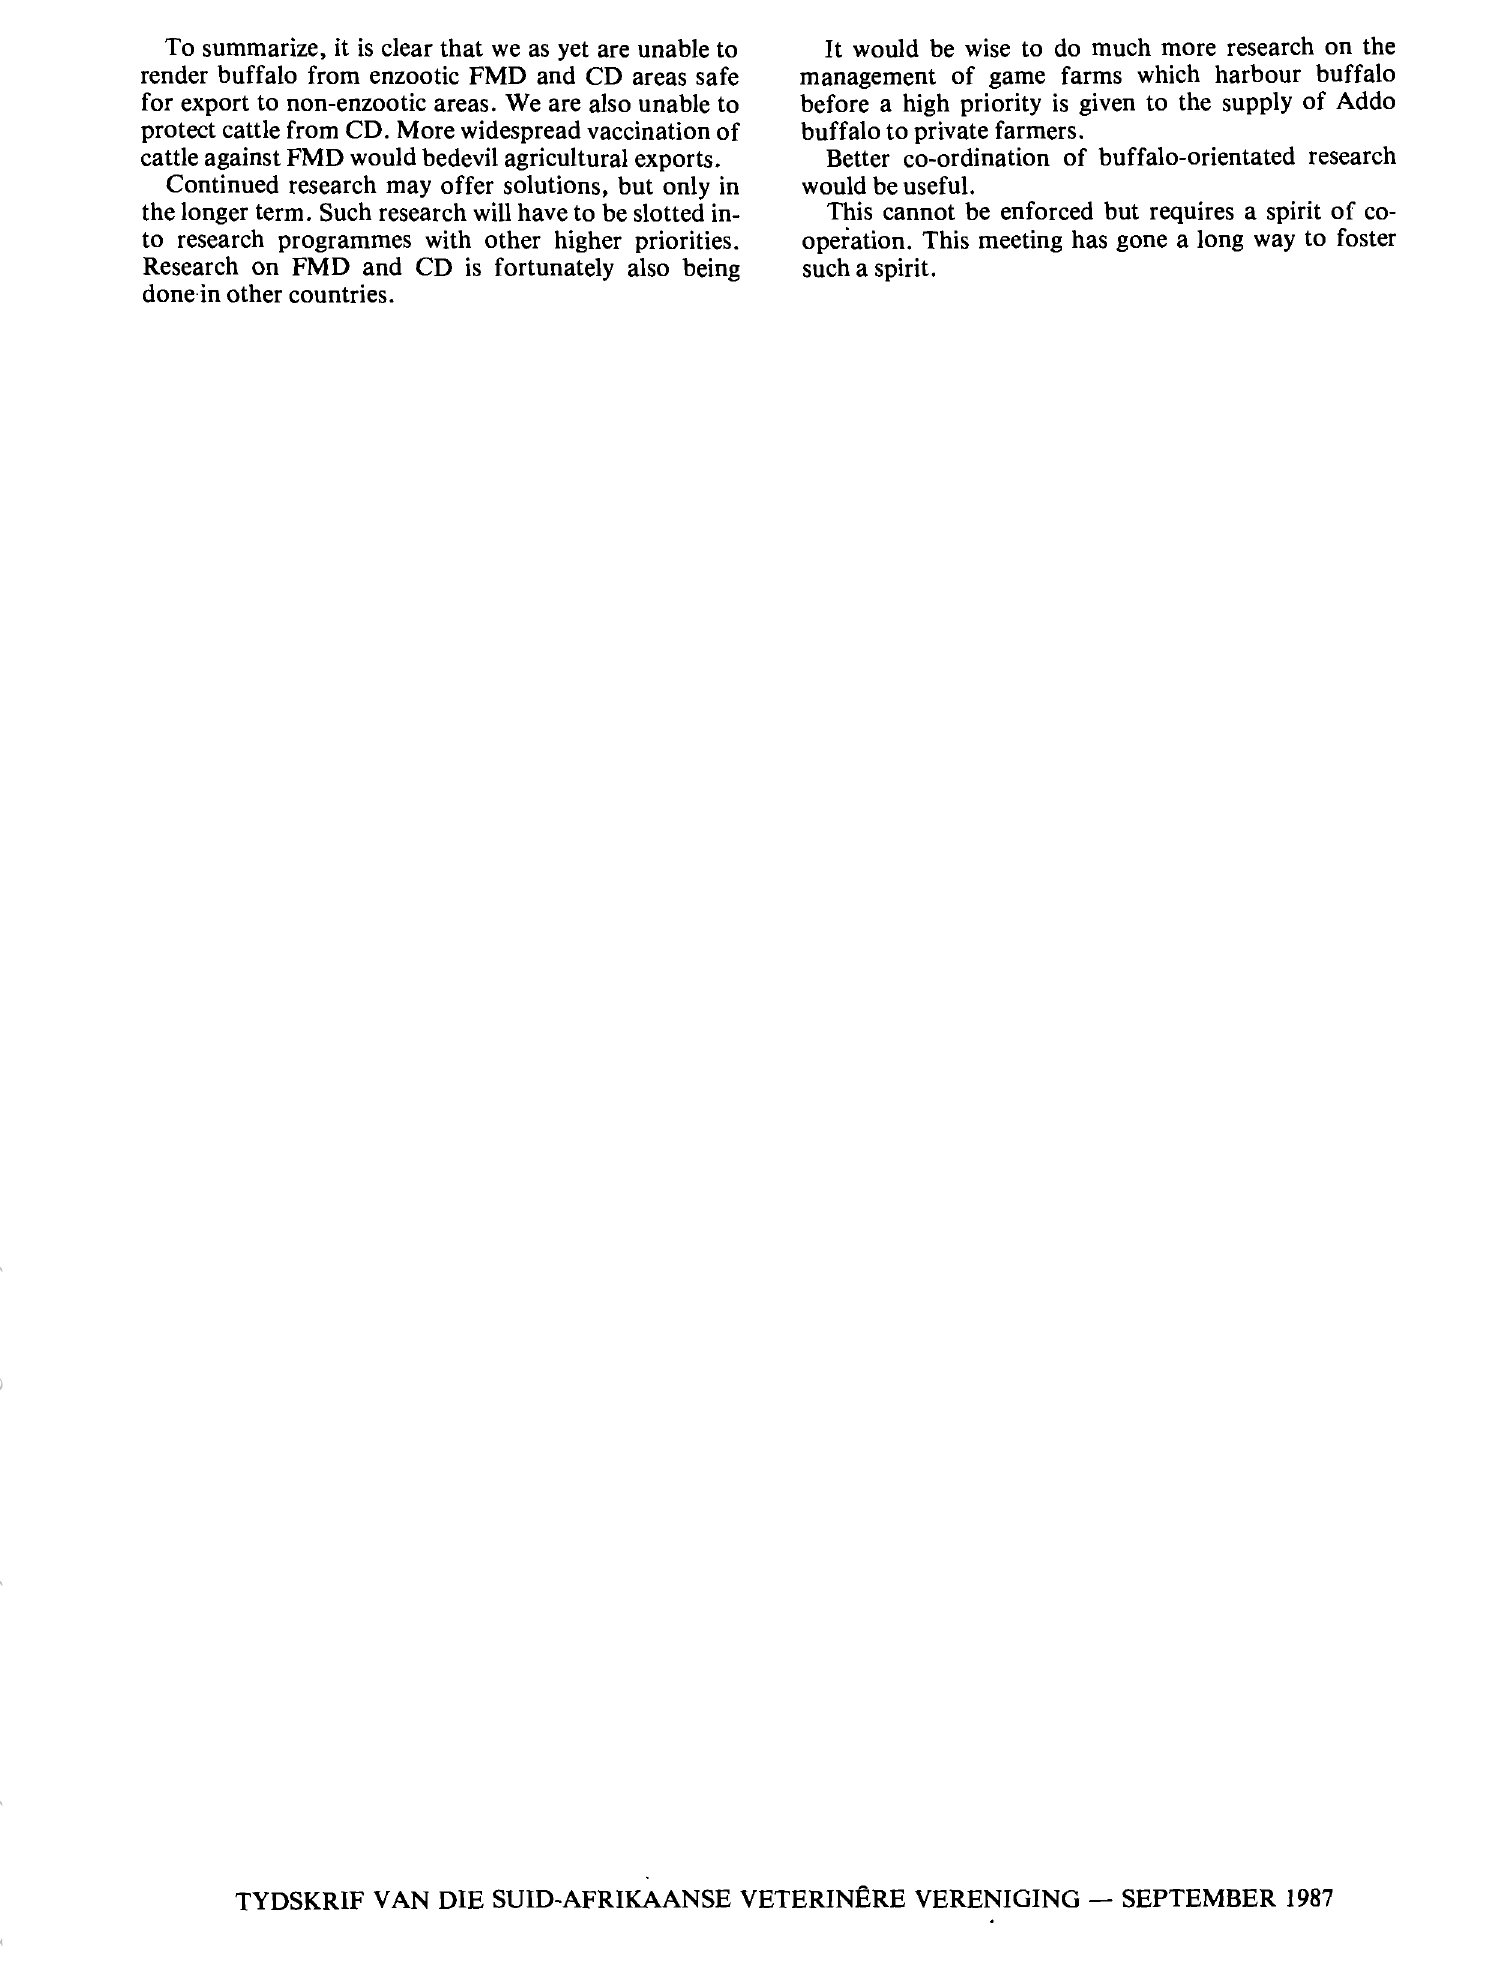
TYDSKRIF VAN DIE SUID-AFRlKAANSE VETERINERE VERENIGING - SEPTEMBER